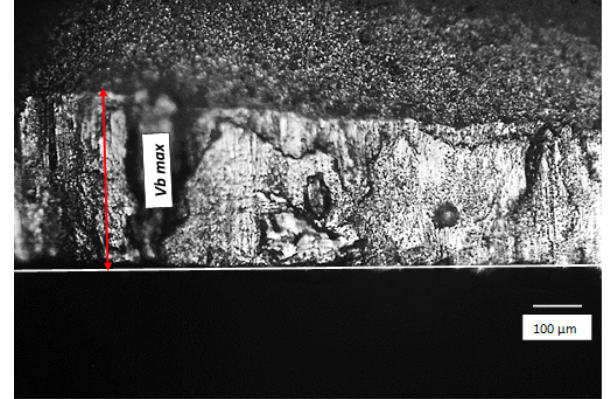
Figure 2. Flank wear measurement using an optical